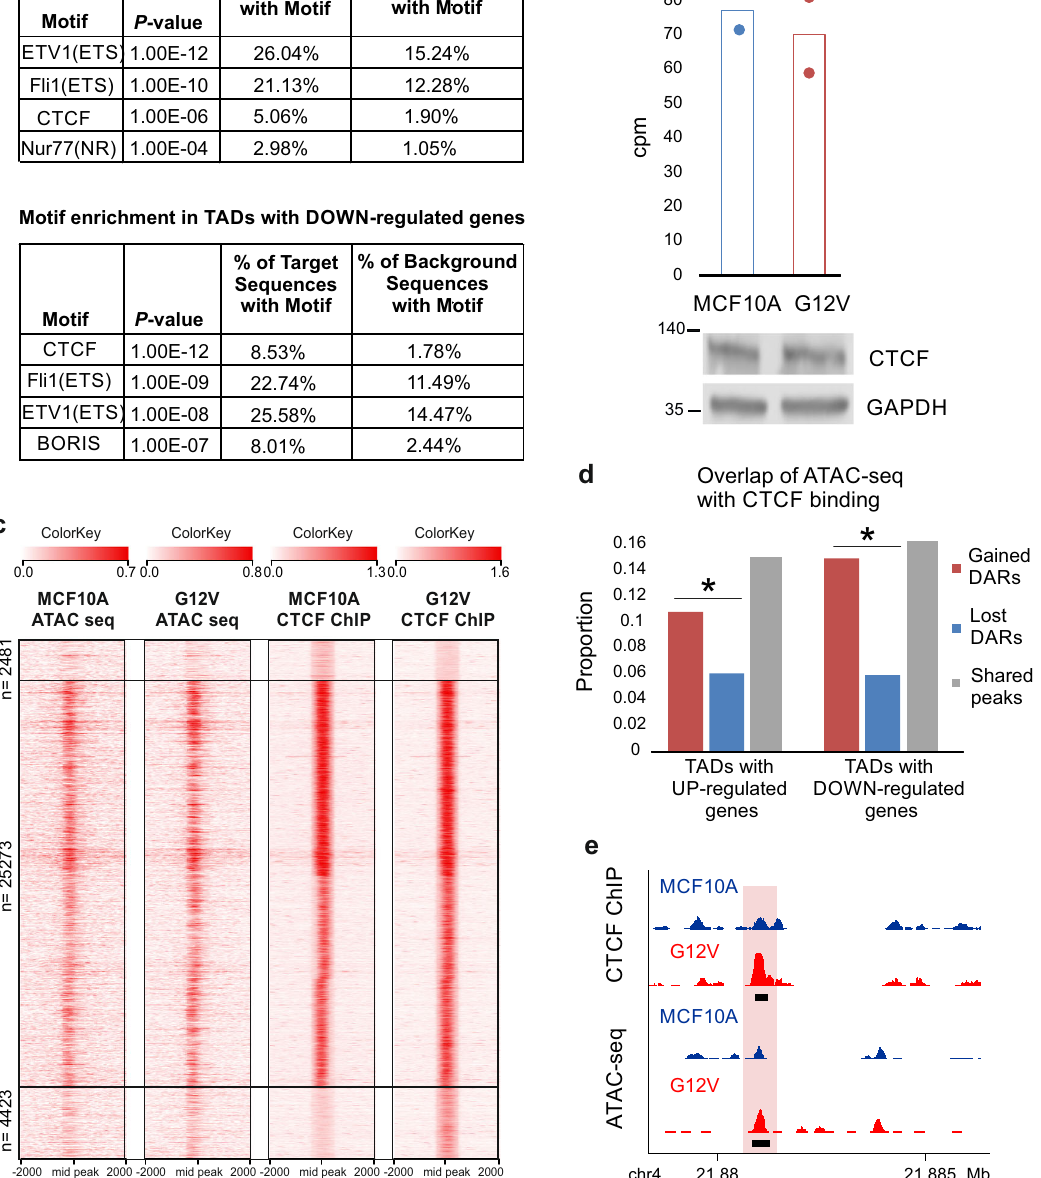
Fig. 5 CTCF motif and binding sites are enriched in gained DARs. a Top motifs enriched in gained DARs within TADs of up- or down-regulated genes. Background group is the lost DARs. b Expression levels of CTCF in MCF10A (blue) and G12V (red) cells determined by RNA-seq. Data points and average (bar graph) are presented. p -value determined by DESeq2 - Wald test corrected for multiple testing using the Benjamini and Hochberg method. CTCF protein levels in MCF10A and G12V cells as measured by western blot analysis (bottom). Representative result of at least two biological repeats is shown. c Heatmap displaying k-means clustering of CTCF ChIP-Seq data in the two cell types. The ATAC-seq data were arranged to match the order of loci found by clustering CTCF ChIP-Seq. Four kb around the ChIP-seq peaks are displayed. d % of gained (blue) and lost (red) DARs overlapping CTCF binding sites in TADs of up- and down-regulated genes. * p < 0.001, proportional test. e Example for a gained DAR that overlaps with gained CTCF binding site (pink box). Black boxes indicate peaks, the black line indicates CTCF motif. Chromosomal coordinates in Mb of human hg19 genome build are indicated at the